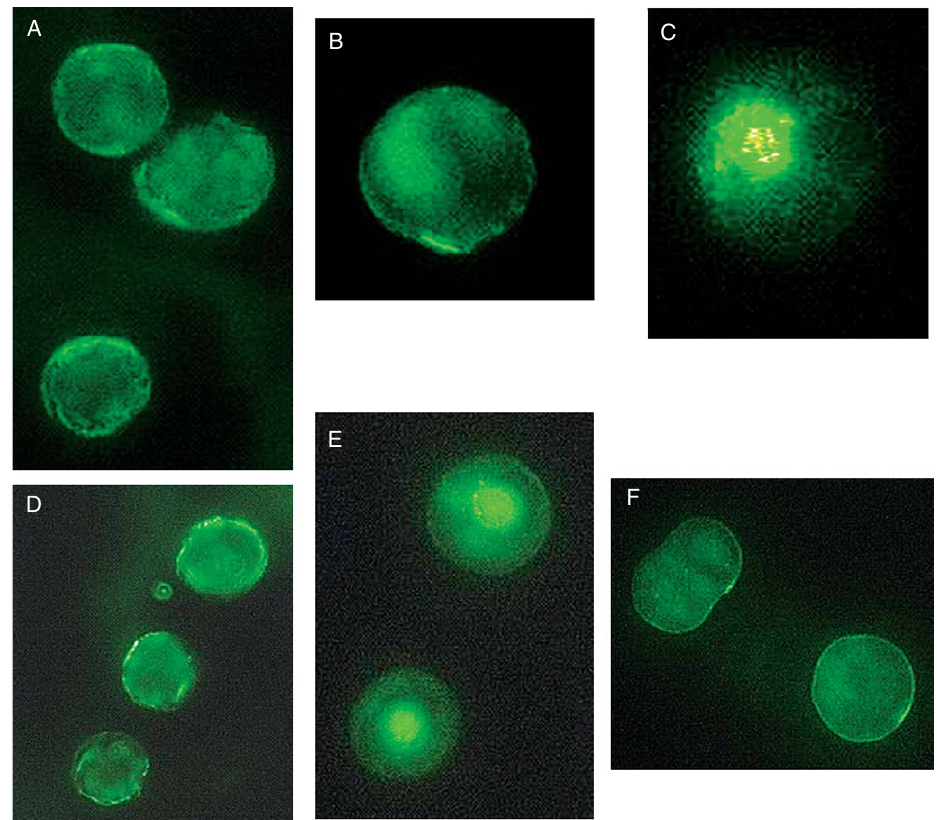
Fig. 3. Immunofluorescent staining for ORC1 in elutriated cells. Cells from the fractions described in Fig. 1 were fixed to the bottom of chamber slides and incubated sequentially with anti-ORC1 and then an ALEXA Fluor-conjugated secondary antibody. Immunostaining was visualized by fluorescence microscopy. A. Fraction 2, cells in early G1. B. Fraction 3, cells in early to mid G1. C. Fraction 4, cells in mid to late G1. D. Fraction 5, cells in late G1 – early S (G1/S boundary). E. Fraction 6, cells in mid to late S phase. F. Fraction 7, cells in G2/M.